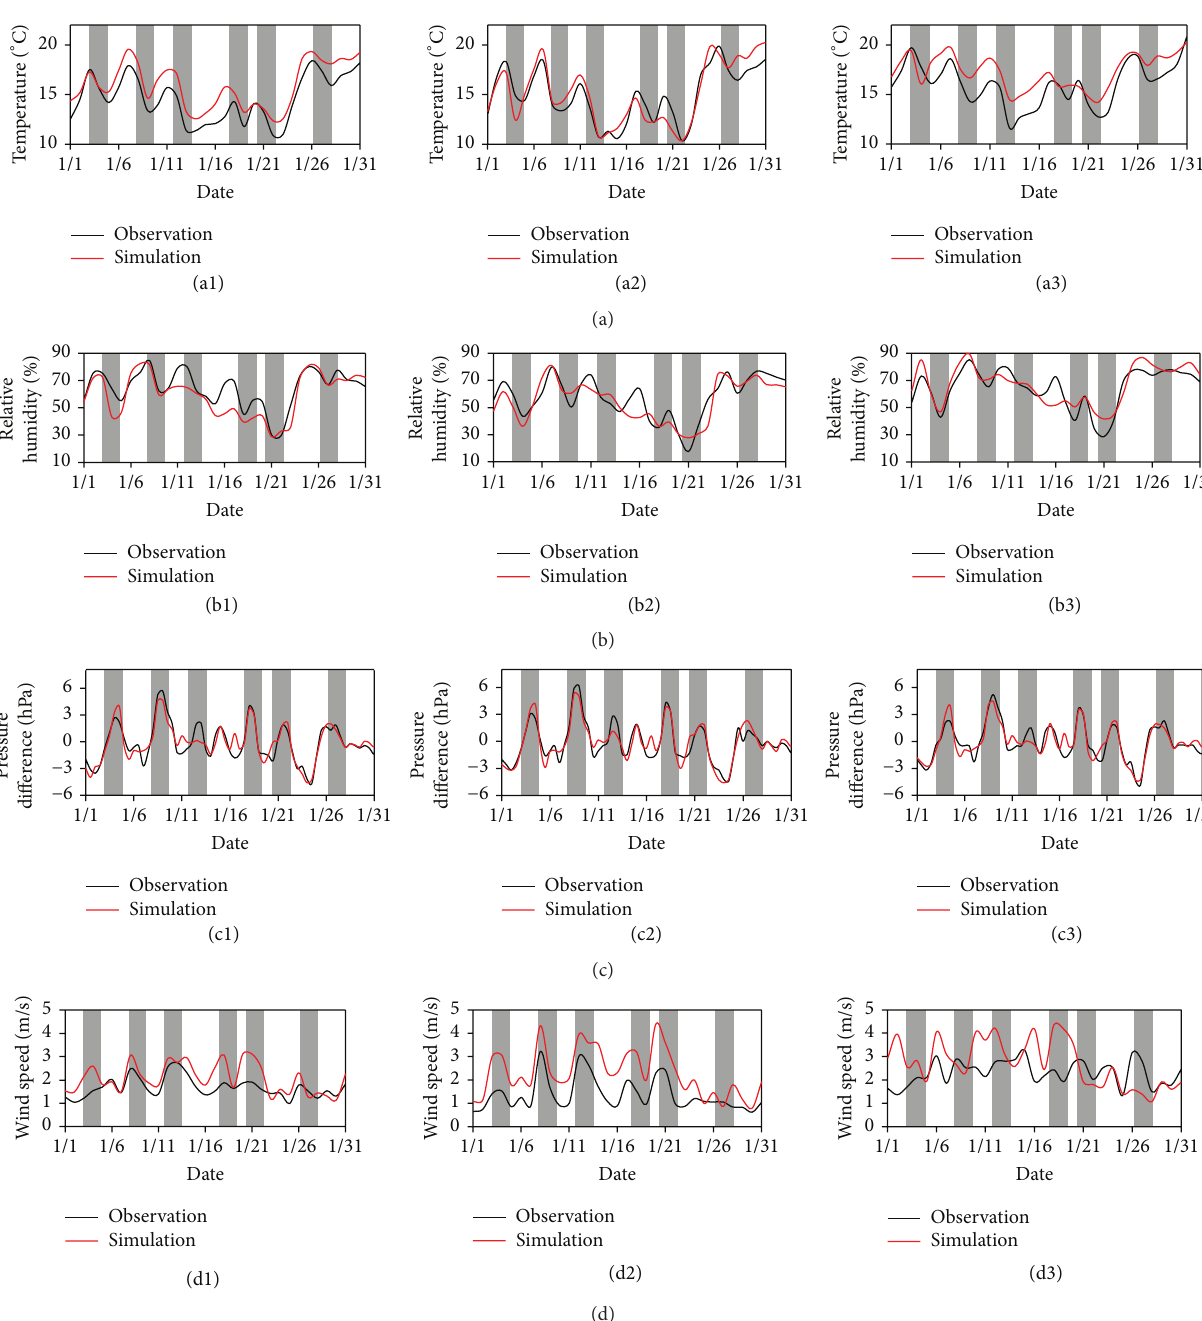
Figure 3: Comparison of simulated (a) daily mean 2m temperature, (b) daily mean relative humidity, (c) 24-hour surface pressure difference, and (d) daily mean wind speed with the observations (1, 2, and 3 of each panel represent Zhongshan, Guangzhou, and Zhuhai station, resp. The shaded areas represent the days with cold front